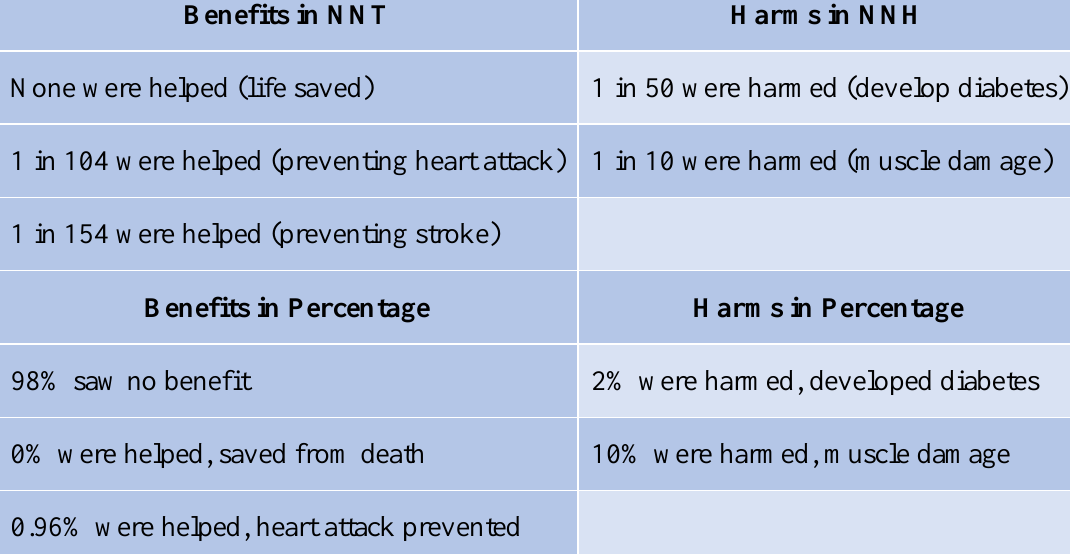
Table 2. Benefits and harms of statin treatment in absence of manifest heart disease. Benefits in NNT Harms in